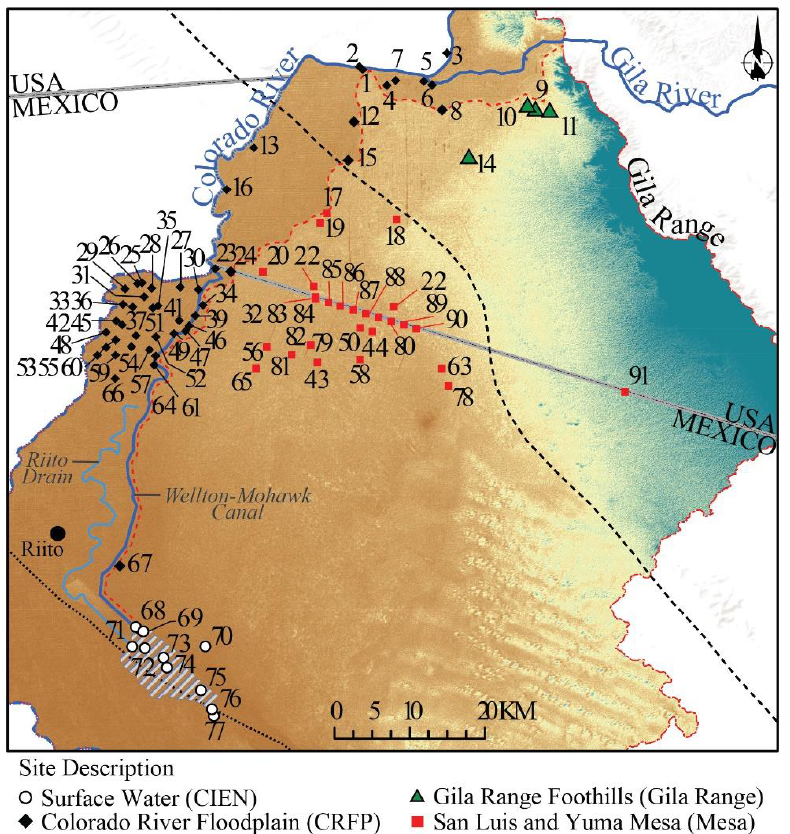
Figure 4. Location of sampling sites in the study area. Symbols for adjacent locations overlap in some cases. The red-dotted line shows the western limit of the San Luis and Yuma Mesas.